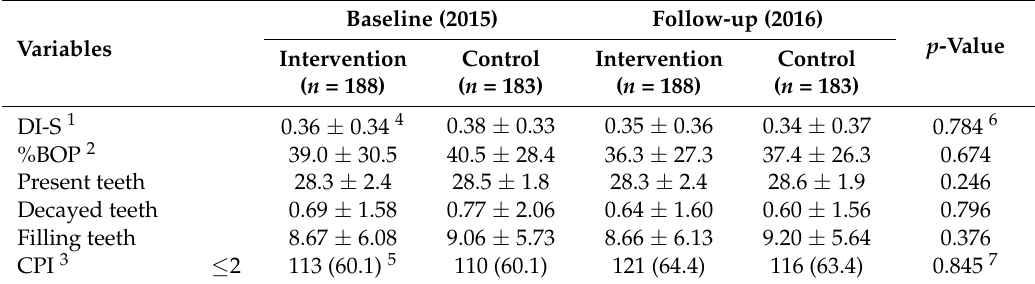
Table 2. Comparison of clinical variables between the intervention group and the control group at follow-up.